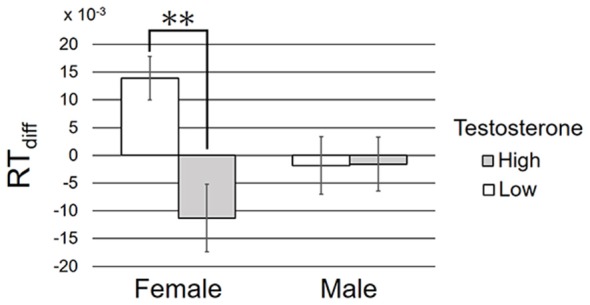
The mean and standard deviation of RTdiff in each condition. **p < 0.01 in the simple main effect analysis.